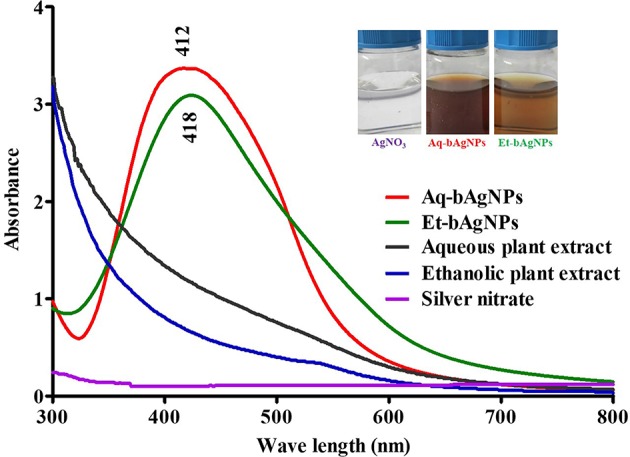
UV-Vis spectra of biogenic silver nanoparticles (bAgNPs).